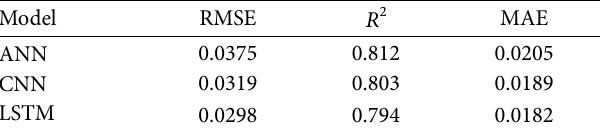
Table 1: Performance comparison of different approaches.